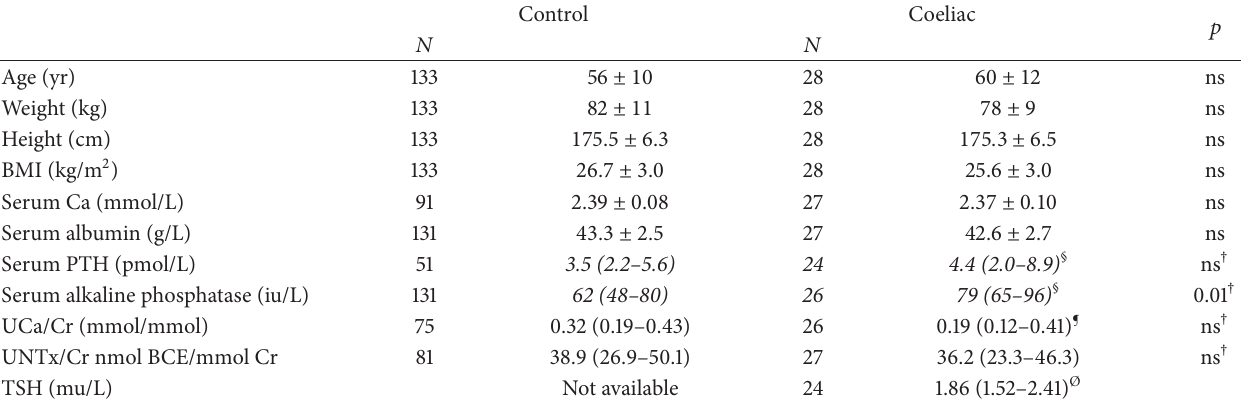
Table 1: Baseline characteristics of the male coeliac patients and age matched healthy control